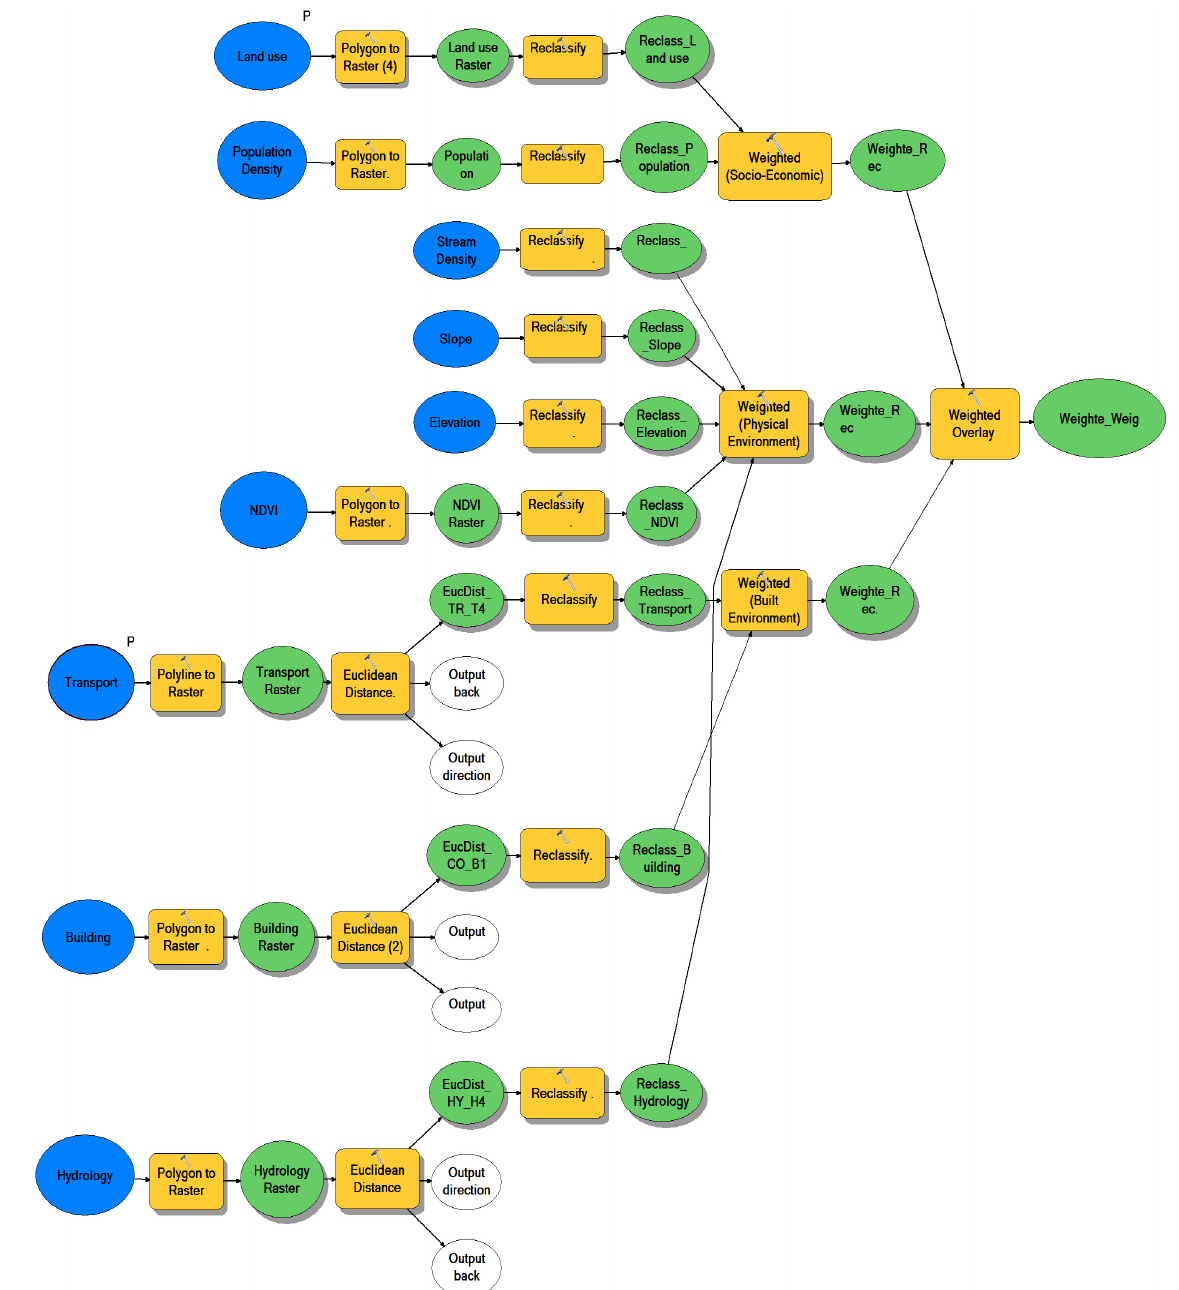
Figure 4. ArcGIS model for creating flood vulnerability map of the Neluwa DSD using Model Builder.